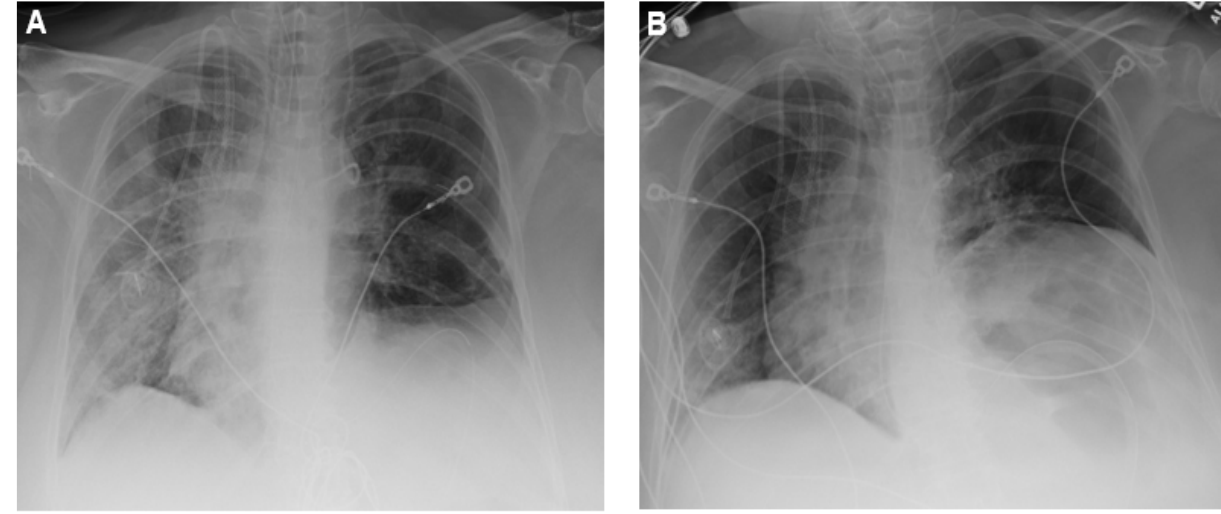
Figure 1. Chest X-rays showing ( A ) baseline bilateral infiltrates on day 0 and ( B ) mild improvement in the patchy airspace opacity in the right lower lobe and stable patchy opacity in the left lower lobe on day